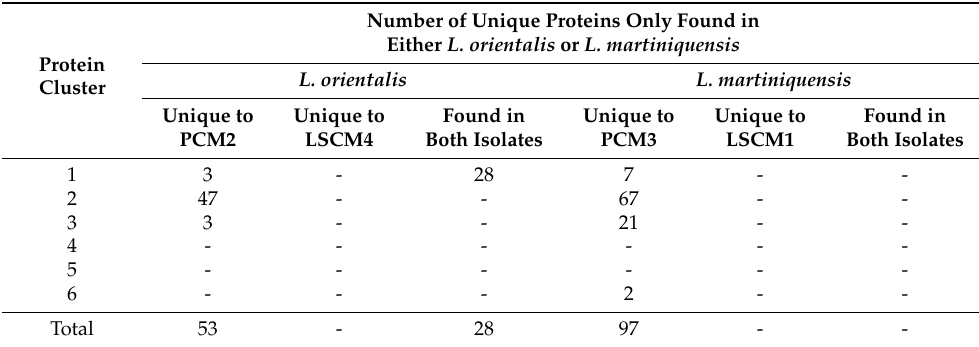
Table 3. Comparison of the annotated proteins that were found only in L. orientalis and L. martiniquensis . The compared numbers are depicted as the proteins uniquely identified in either of the two isolates or both. The “-” sign indicates the absence of the unique proteins in that isolate. Number of Unique Proteins Only Found in Either L. orientalis or L. Protein Cluster